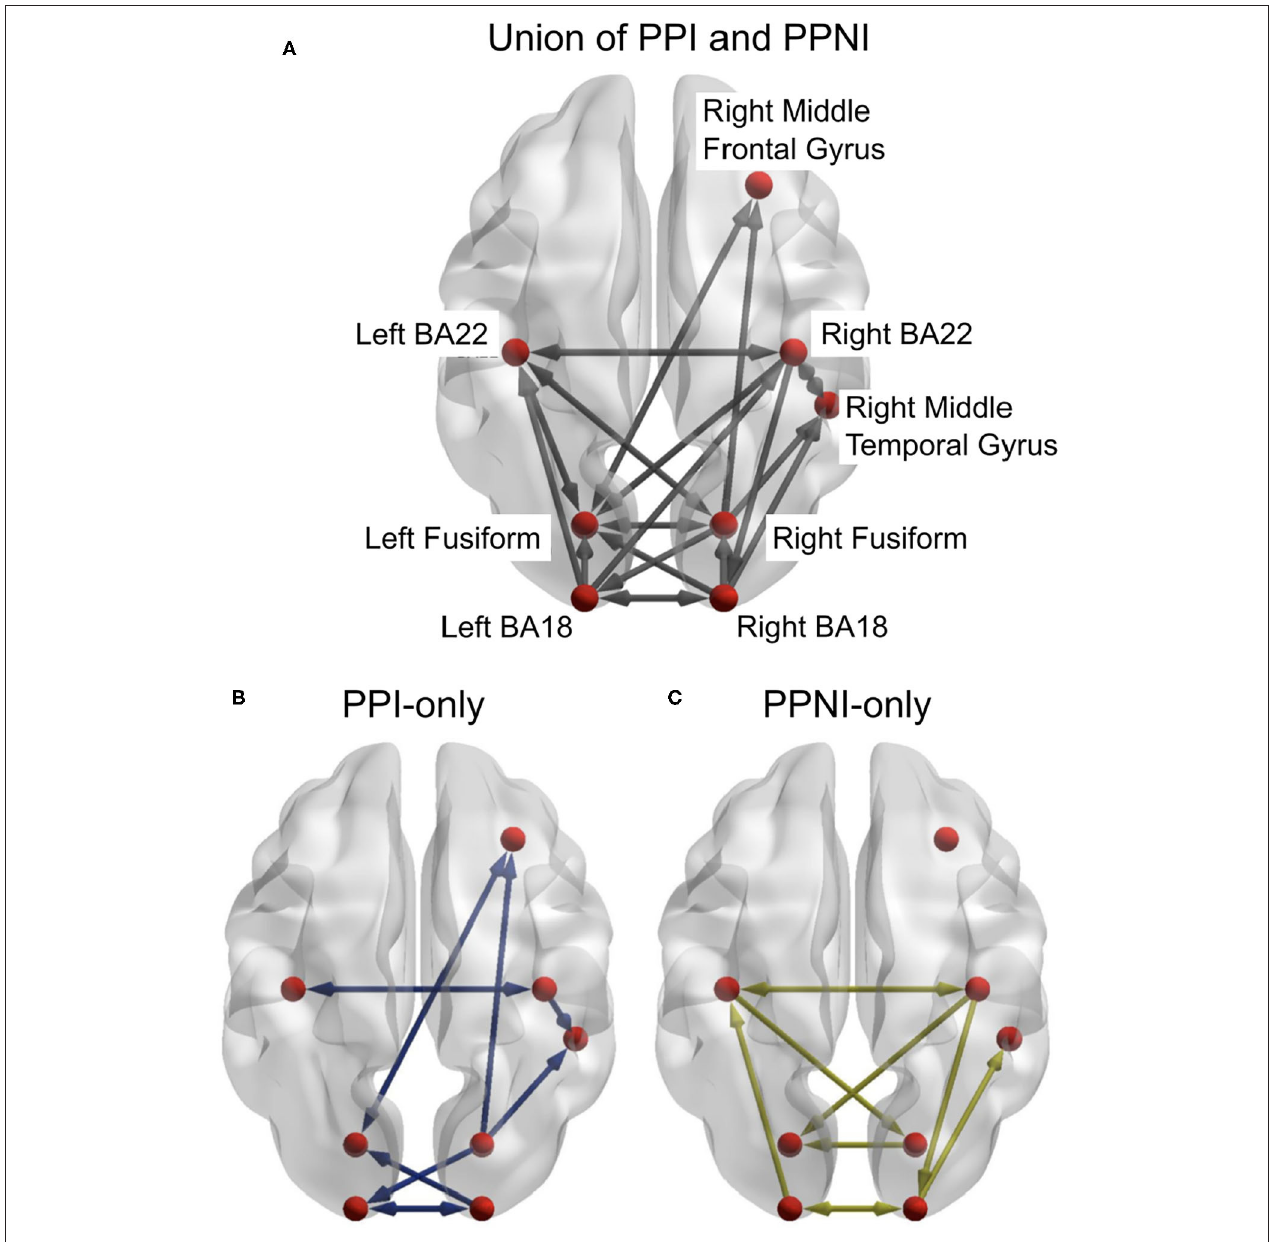
FIGURE 4 | (A) The combined results from the transfer entropy analyses of the trials for propensity to perceive illusion (PPI) and propensity to perceive no illusion (PPNI). This also includes links that are associated with both percepts. (B,C) represent the differences between the PPI and PPNI group networks, respectively, and the union network. Connections which are present in (A) but not in (B) or (C) indicate that those connections are present in both conditions. Figures generated with BrainNet Viewer (Xia et al., 2013).